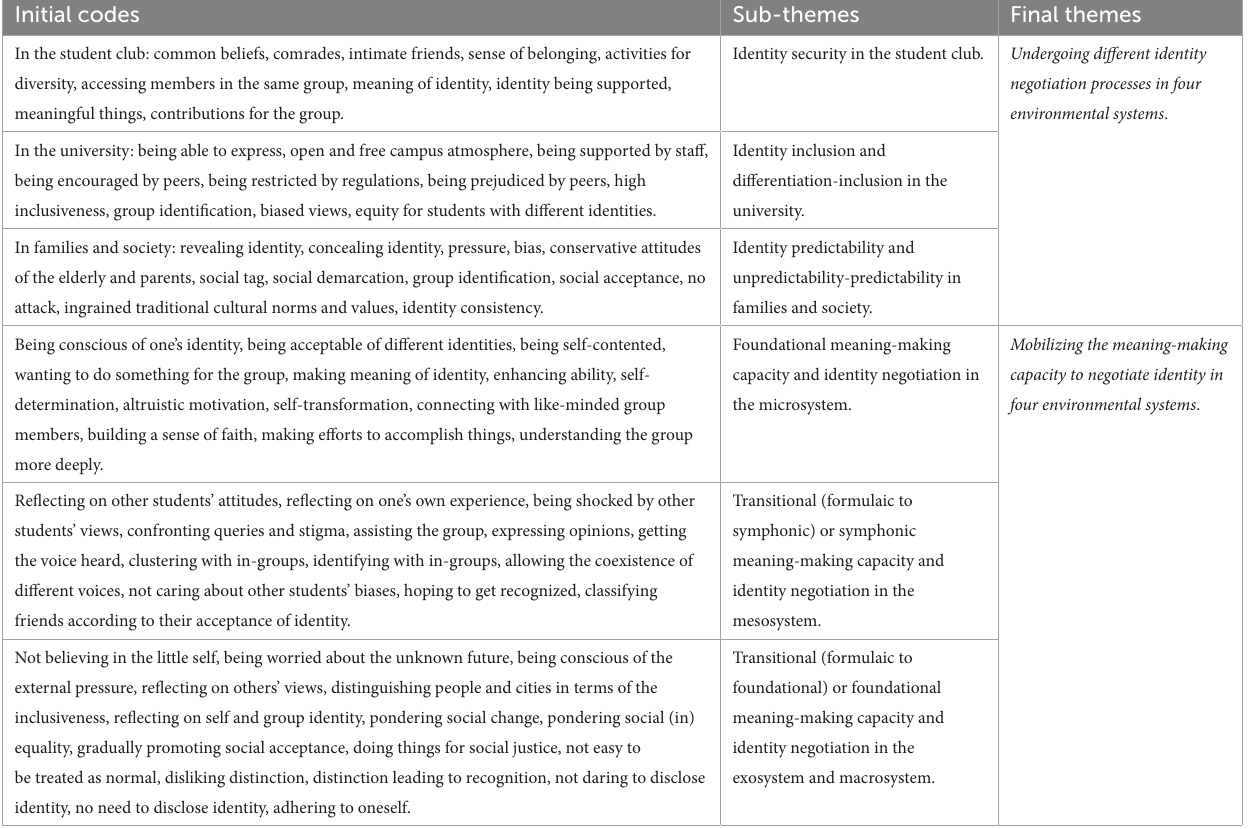
TABLE 2 The coding